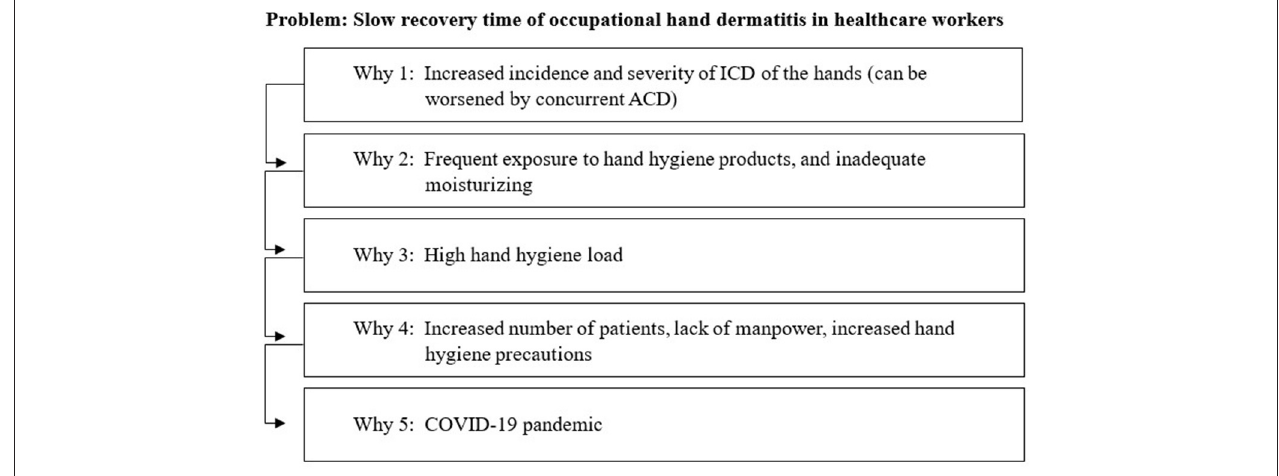
FIGURE 1 | Root-cause analysis using the 5 Whys technique.